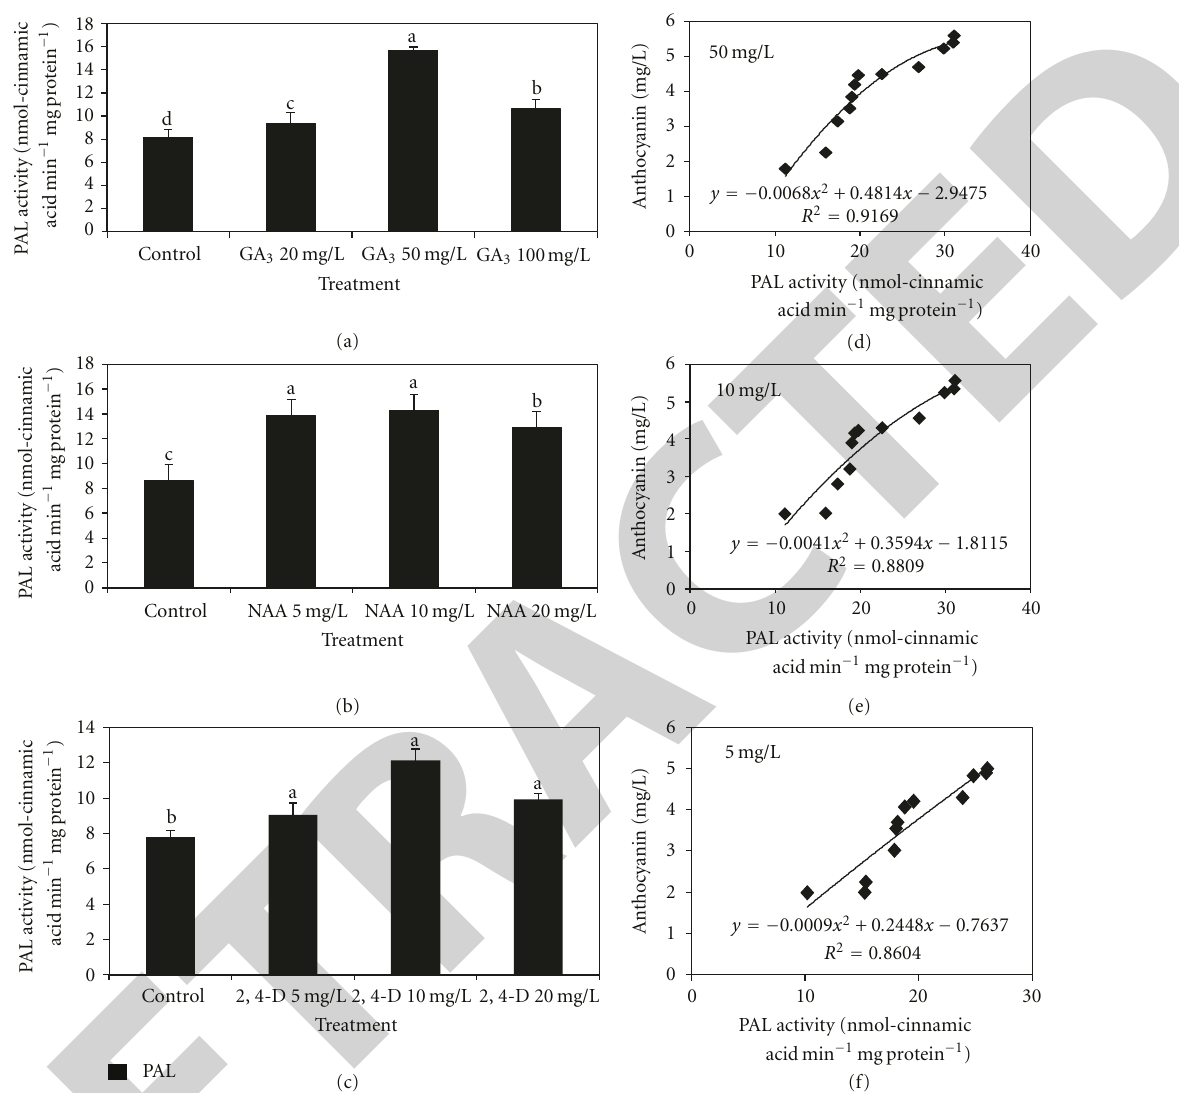
Figure 2: E ff ects of treatments of GA 3 (a) and (d), NAA (b) and (e) and 2,4-D (c) and (f) on PAL activity and correlation between PAL and anthocyanin synthesis in wax apple fruits. Data are means of six replicates ± SE. Di ff erent letters represent the significance at the 5% level of LSD